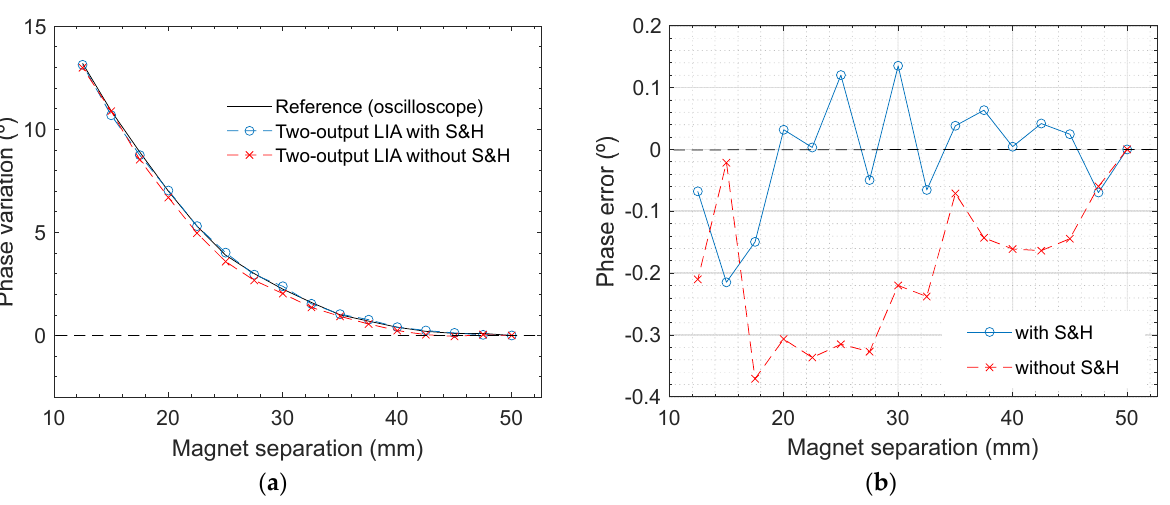
Figure 10. Phase variation measurements of the two-output LIAs compared with the reference value provided by the digital oscilloscope, versus the separation between the GMI sensor and magnet. The phase value with a magnet separation of 50 mm was set as the reference (0 o ): ( a ) representation of the phase variation with and without frequency downscaling; and ( b ) phase error.